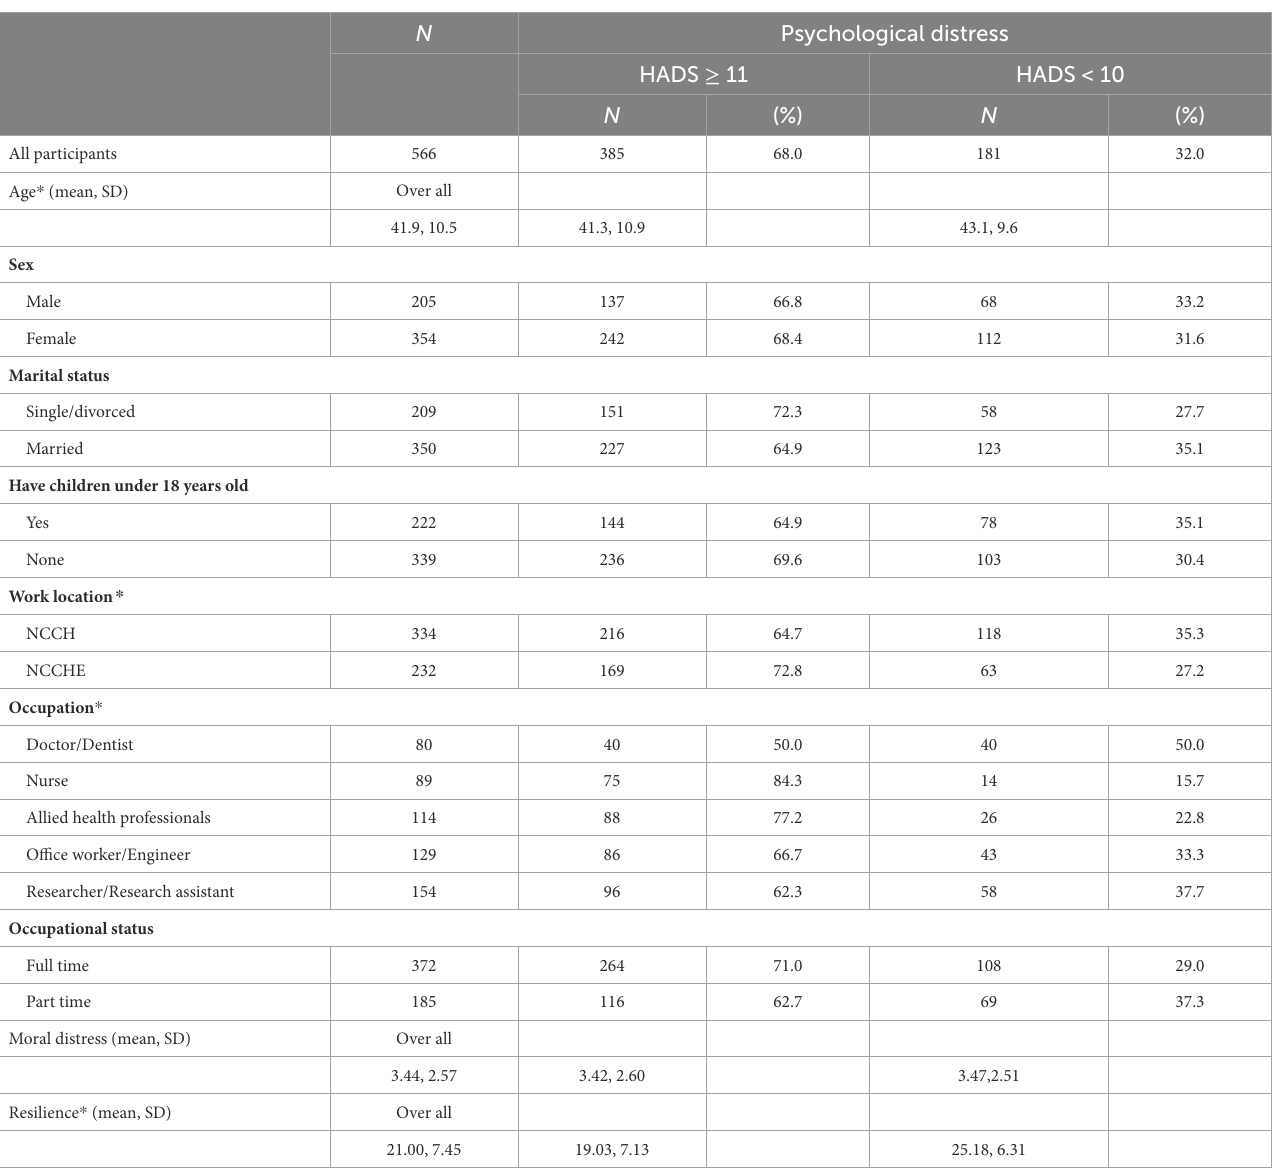
TABLE 1 Characteristics of participants and psychological distress ( N =